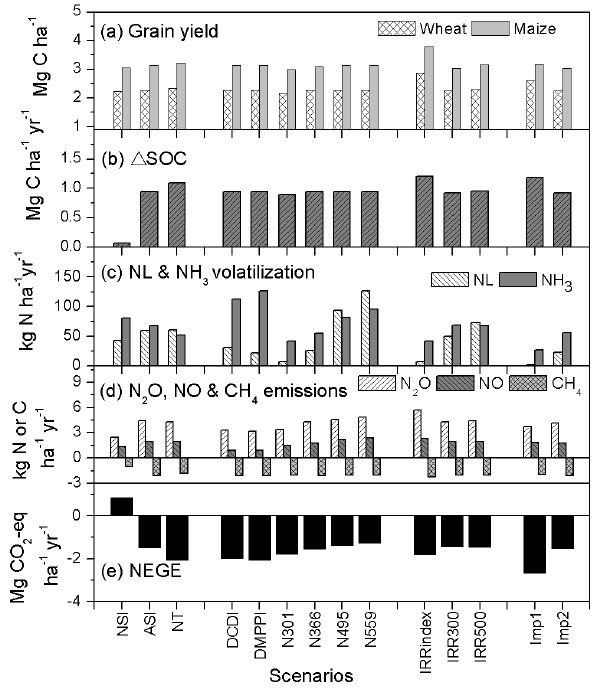
Fig. 8. Averages of the crop yields, soil organic carbon change (SOC), nitrate leaching (NL), ammonia (NH 3 ) volatilization, emis- sions of nitrous oxide (N 2 O), nitric oxide (NO) and methane (CH 4 ), and net emission of greenhouse gases in the ecosystem (NEGE) simulated over a 20yr period for different management scenarios. The definitions of each scenario can be found in Table 2. NEGE is defined as CH 4 +N 2 O − SOC and expressed as a CO 2 equivalent Fig. 7. Modeled yields of wheat and maize, soil organic car- based on the 100yr global warming potentials, i.e., 25 for CH 4 and bon change ( 1 SOC), nitrate (NO − ) leaching, ammonia (NH 3 ) 3 298 for N 2 O (IPCC, volatilization, emissions of nitrous oxide (N 2 O) and nitric oxide (NO) over a 20-year period for the scenarios with all straw incorpo- ration (ASI) and no straw incorporation (NSI). The simulation was driven by the observed daily temperature (maximum and minimum) and precipitation from 1991–2010.